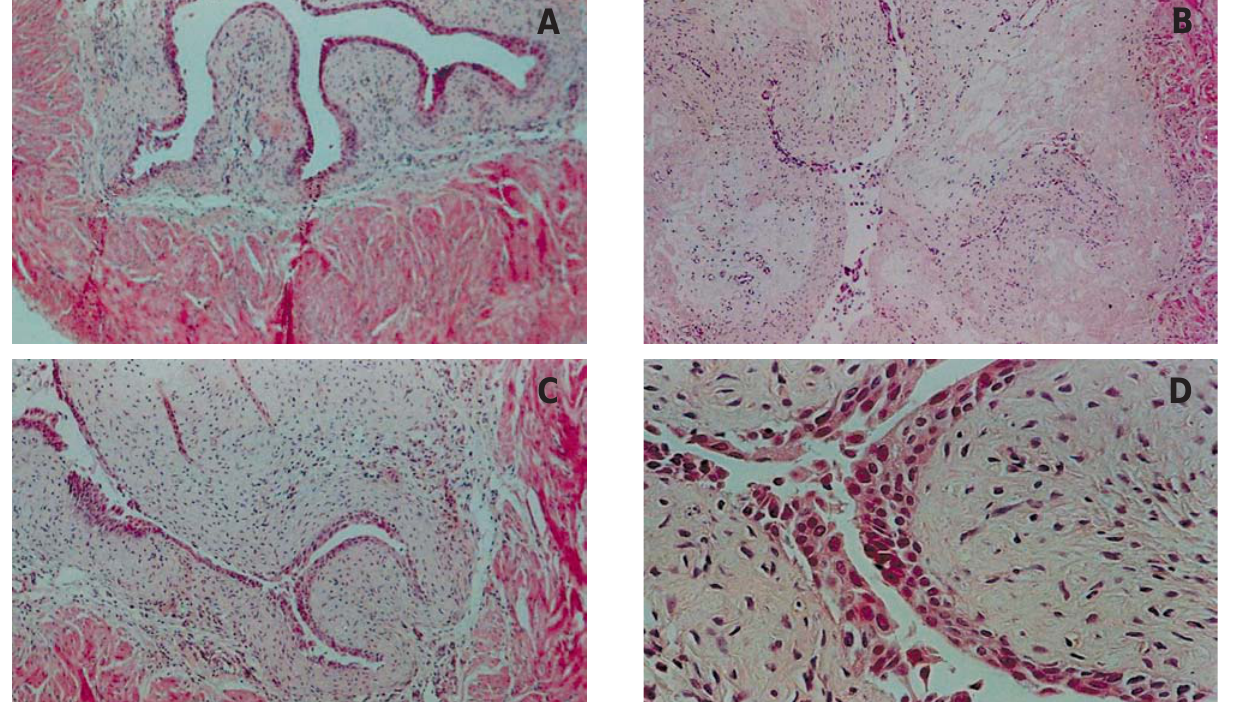
Figure 2 – Histological analysis of cross sections of representative bladder walls. A) Control group which received only saline. B) Ifosfamide at 400 mg/kg induced urothelium desquamation, edema, pronounced hemorrhage and fibrin deposition and leukocyte infiltra- tion when compared to control, shown in A. C) and D) Pretreatment with rhIL-11 at 625 µ g was capable of reducing these side effects. (HE, A, B and C X100 and D